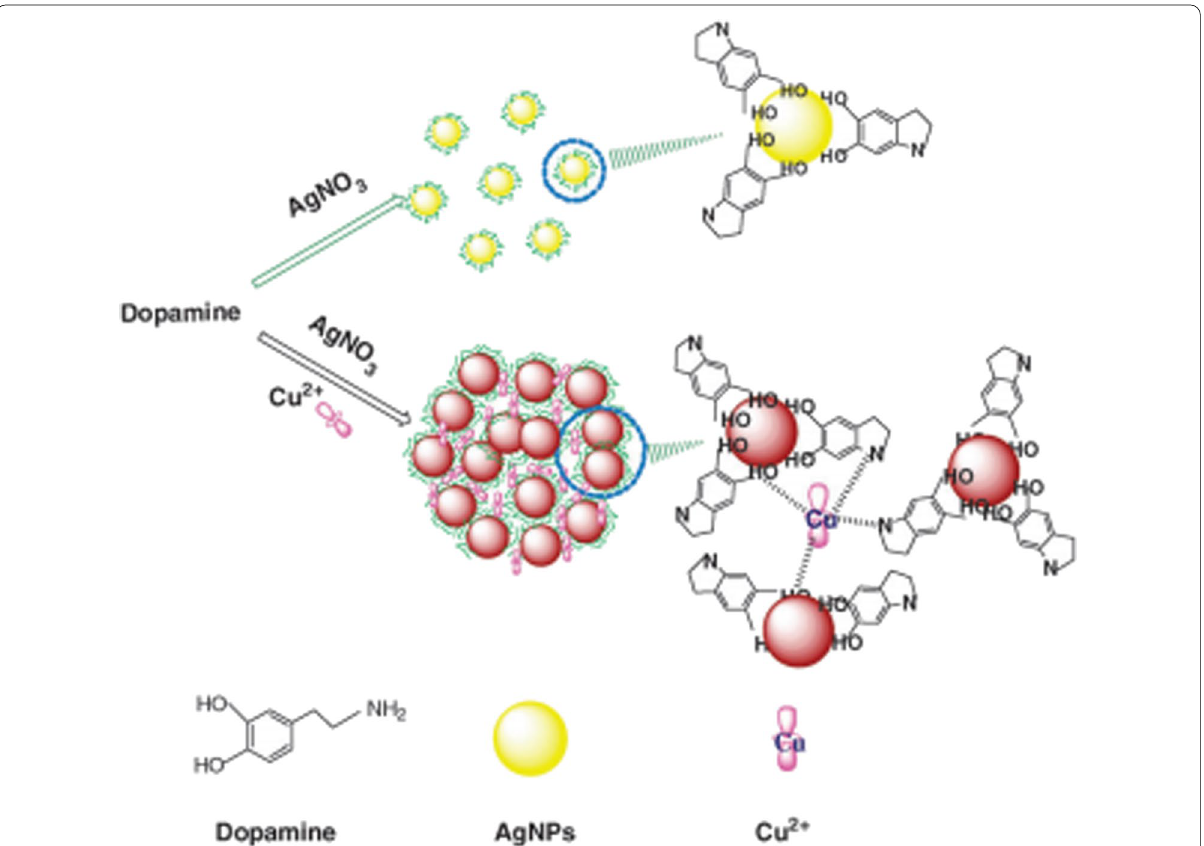
Fig. 6 Mechanism of colorimetric detection of Cu(II) ion (Ma et al.